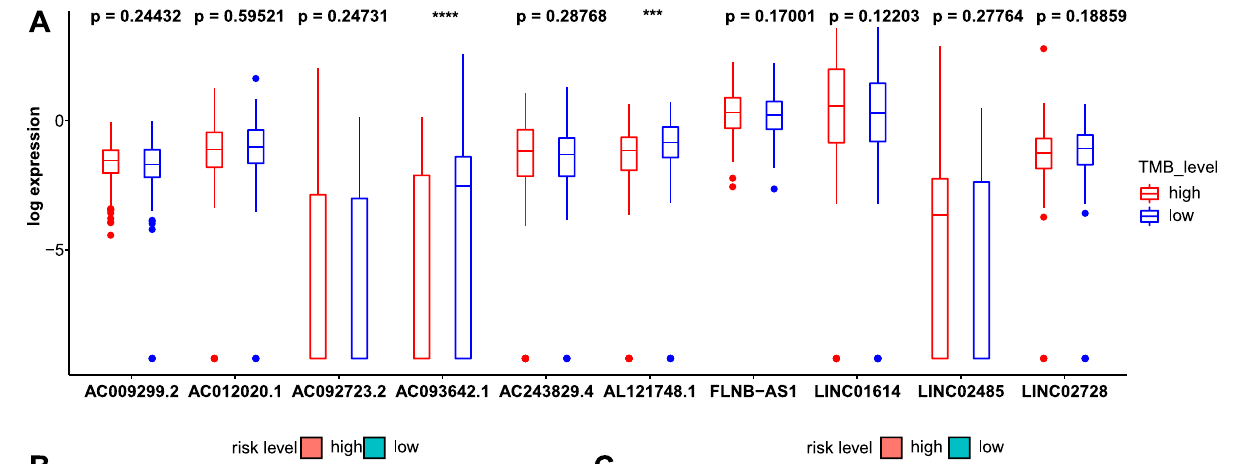
FIGURE 9 | Immune checkpoint inhibitor (ICI) therapy response was assessed through the TMB and TIDE scores in the test2 cohort. (A) The expression values of these 10 lncRNAs were compared in different TMB levels. (B) The TMB was signi fi cantly distinct in the high- and low-risk groups. (C) Patients in the high-risk group had higher TIDE scores indicating a higher chance of immune evasion. (D) Risk scores for patients who responded to ICI therapy and those who did not were